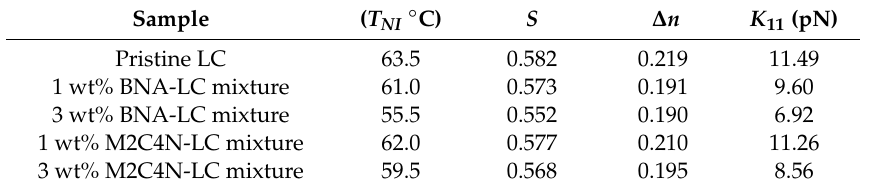
Table 1. Concentration-dependent T NI , S , ∆ n , and K 11 of BNA-LC and M2C4N-LC mixtures.